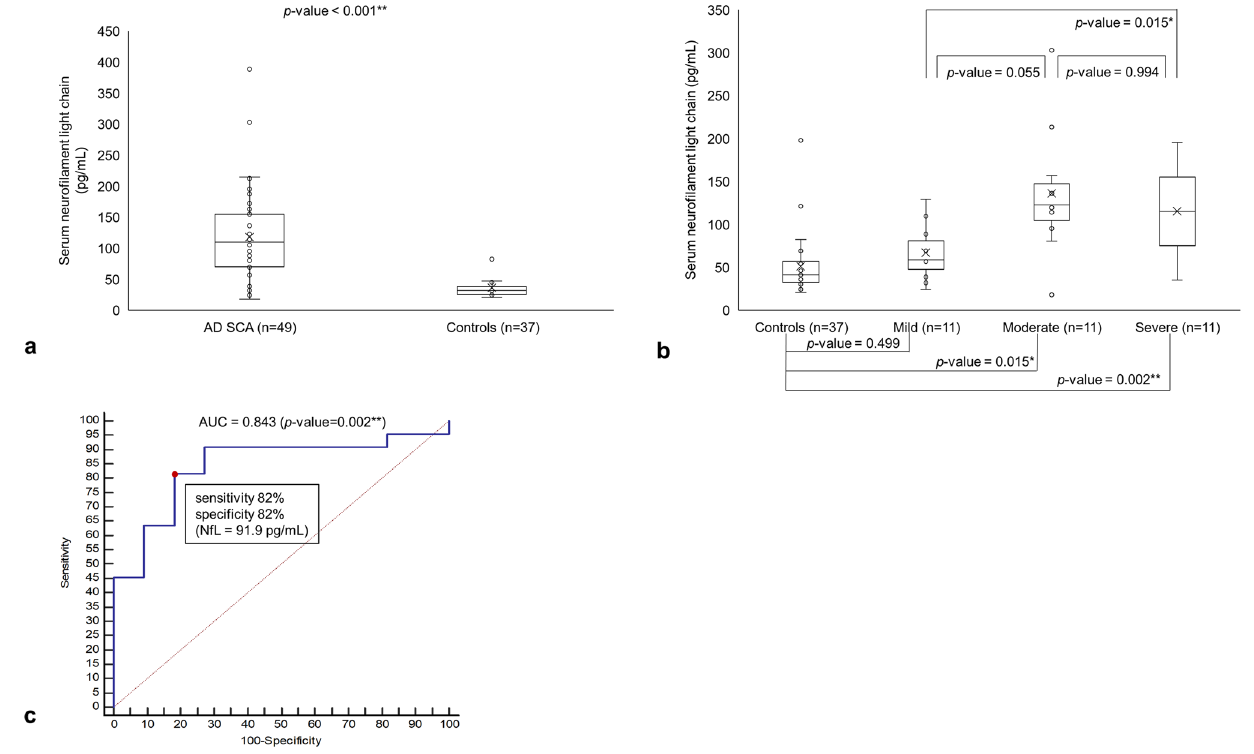
Figure 1. Serum neurofilament light chain in different severity groups of autosomal-dominant SCA and the controls. (a) Comparison of serum NfL chain level in autosomal-dominant SCA patients (n = 49) and the controls (n = 37). (b) Comparison of NfL levels among mild (SARA score ≤ 10), moderate (10 < SARA score ≤ 13), and severe (SARA score > 13) groups of autosomal-dominant SCA patients. (c) ROC curve of serum NfL level for distinguishing moderate and severe autosomal-dominant SCA patients from mild SCA patients. Area under the curve (AUC value was 0.843 (95% CI, 0.702–0.984, p -value = 0.002). ** is for p -value < 0.01, and * is for p -value < 0.05.